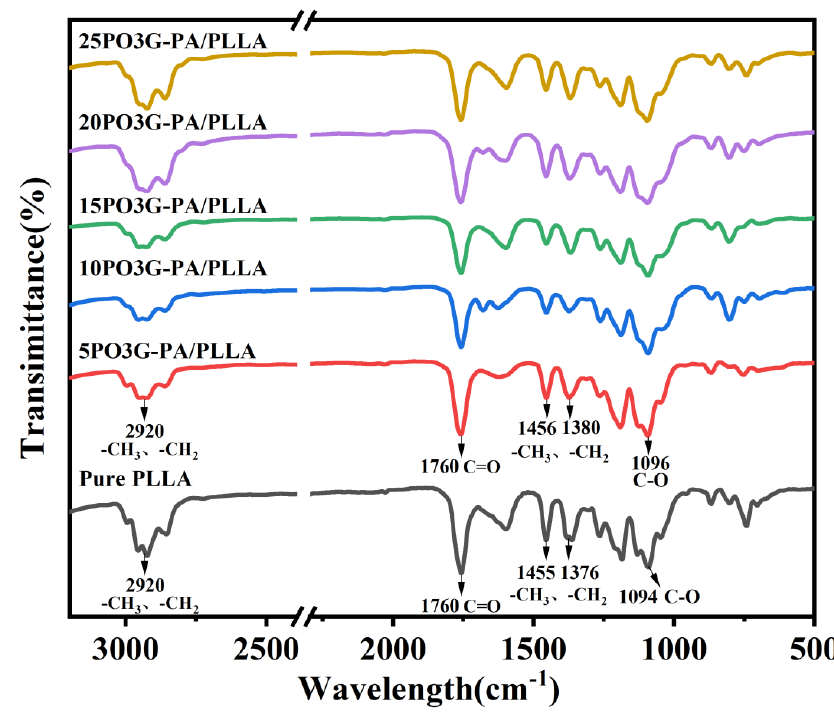
Figure 4. Infrared spectra of PO3G–PA/PLLA composite films with different ratios.